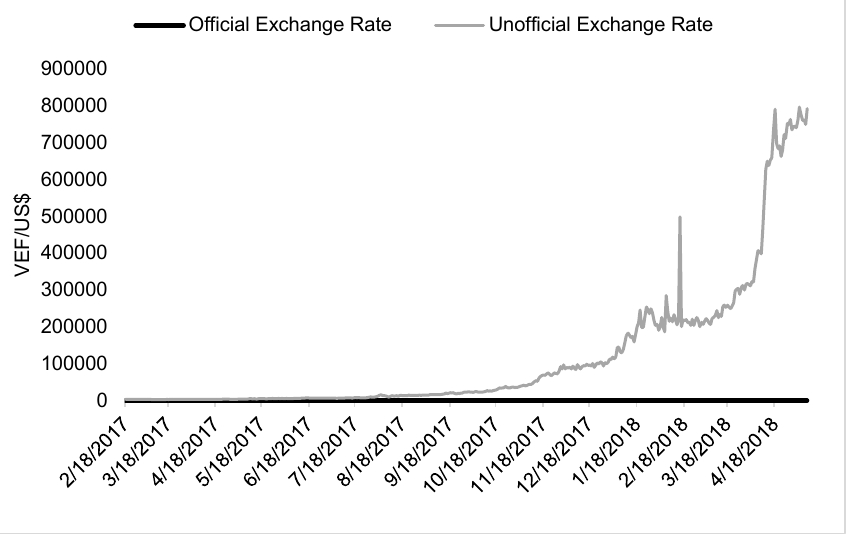
Fig. 3. Venezuelan official and unofficial exchange rates from 18 February 2017 to 9 May 2018 when the official exchange rate is set at 10.0